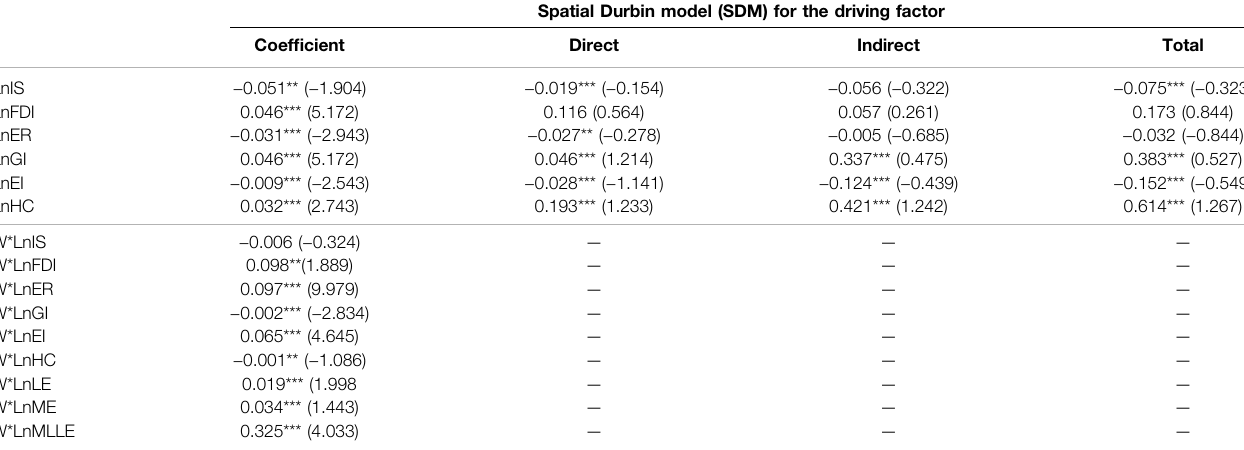
TABLE 8 | Estimation and test results based on the spatial Durbin model (SDM) for the driving